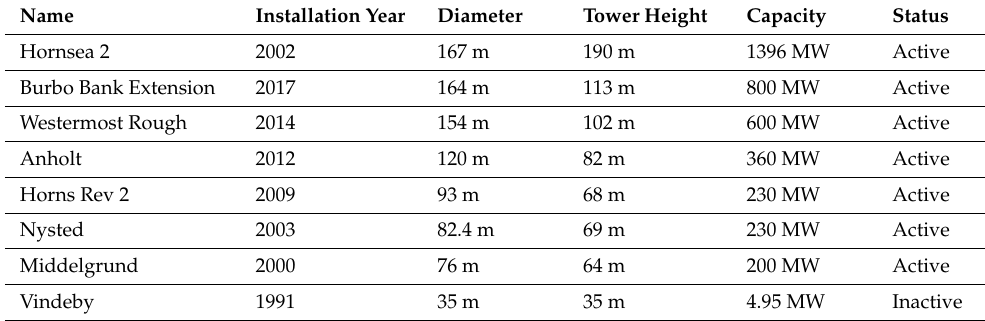
Table 3. List of some offshore wind farms by